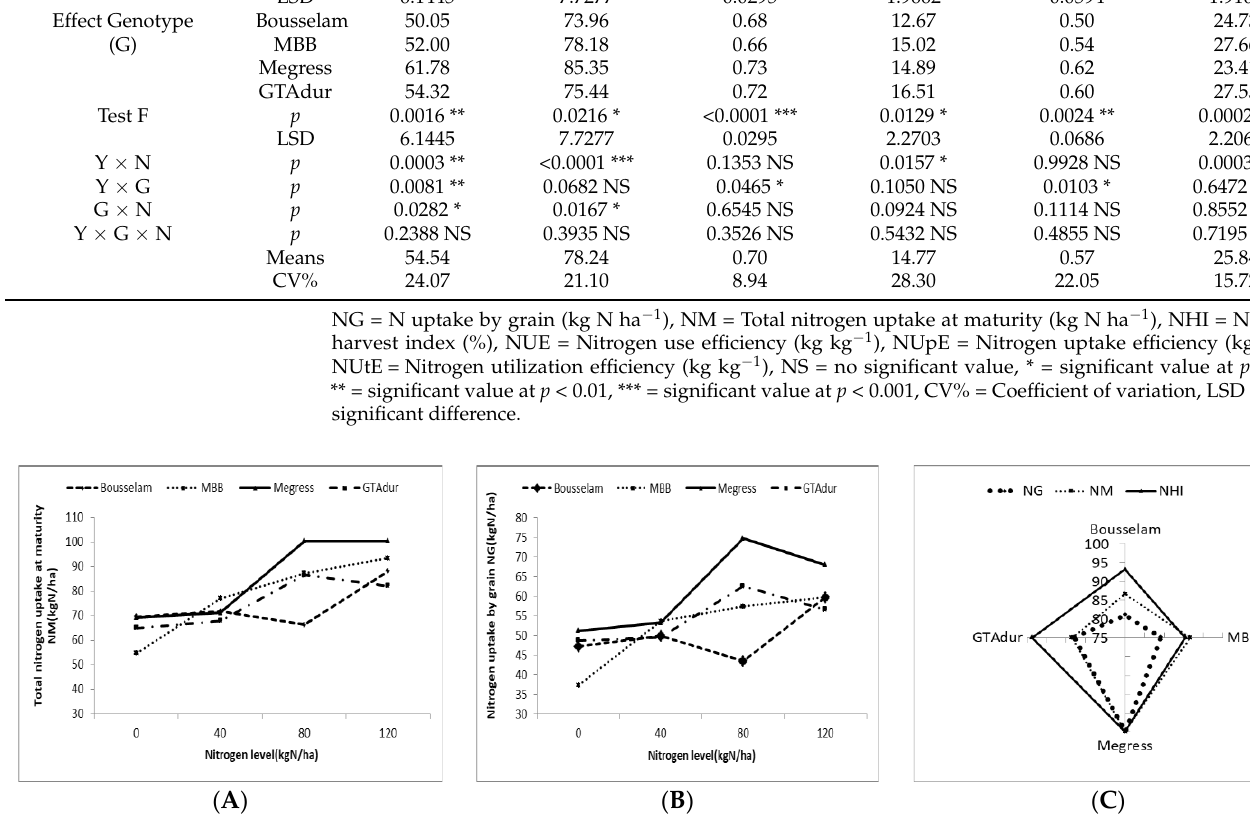
Figure 3. Total nitrogen uptake by whole plant ( A ) and by grain ( B ) as affected by nitrogen level and genotype performance to uptake nitrogen ( C ). NG = N uptake by grain (kg N ha − 1 ), NM = Total nitrogen uptake at maturity (kg N ha − 1 ), NHI = Nitrogen harvest index (%). Table 5. Means and ANOVA results of NG, NM, NHI, NUE, and their components. NG NM NHI NUtE